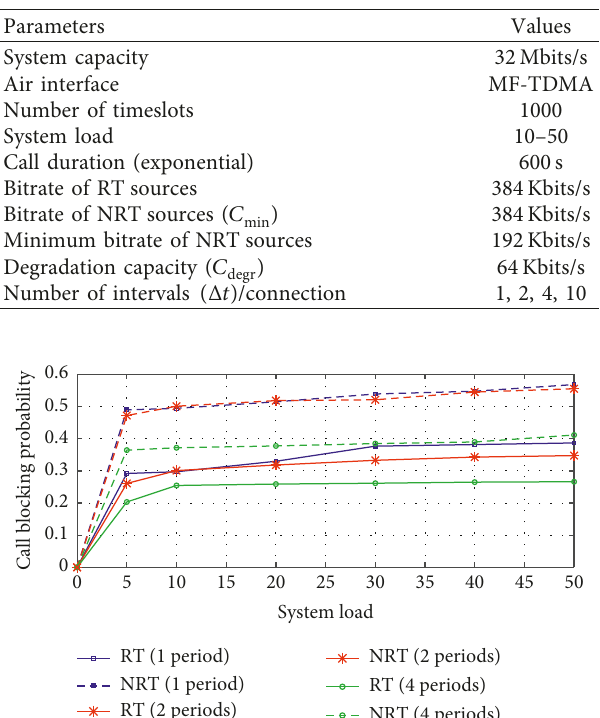
Table 4: Simulation parameters.